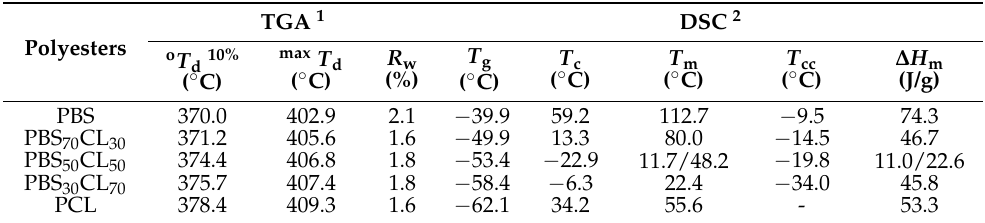
Table 4. Thermal properties of PBS and PCL polyesters and PBS x CL y copolyesters.